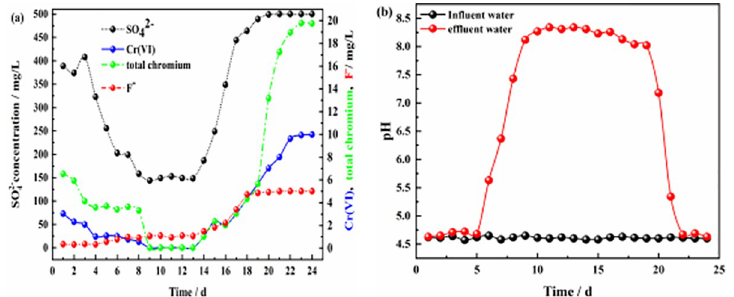
Fig 9. Effluent of dynamic column #4. (a) Effluent concentration of each pollutant ion; (b) pH values of influent and effluent